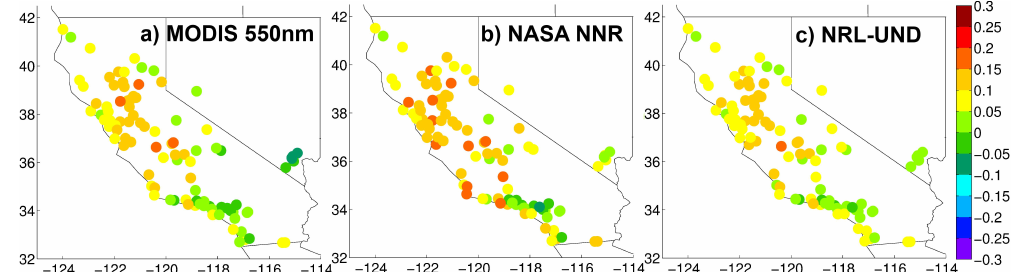
Fig. 7. PM 2 . 5 fractional error reductions from non-assimilated to assimilated models at AQS sites for May 2010. Positive values represent error